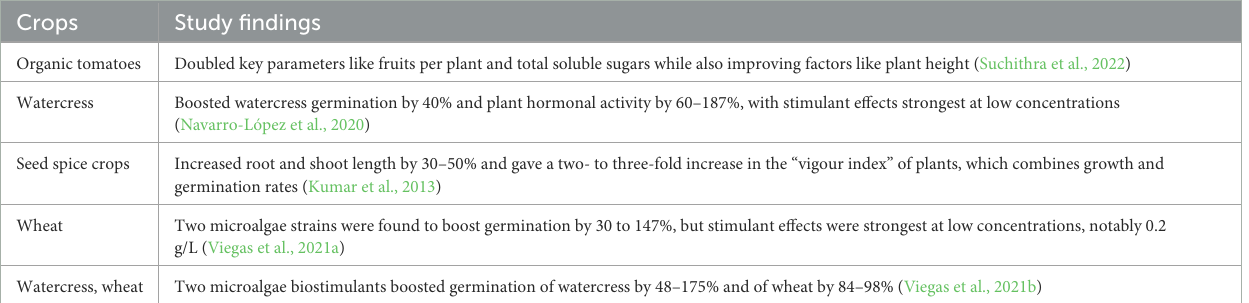
TABLE 5 Efficacy of microalgae-based biostimulants on crops. Crops Study findings Organic tomatoes